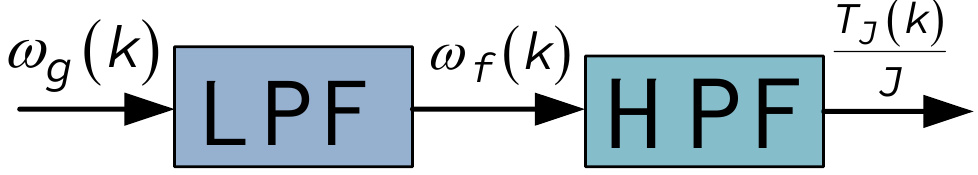
Figure 7. Measurement of inertia torque using a high-pass filter.